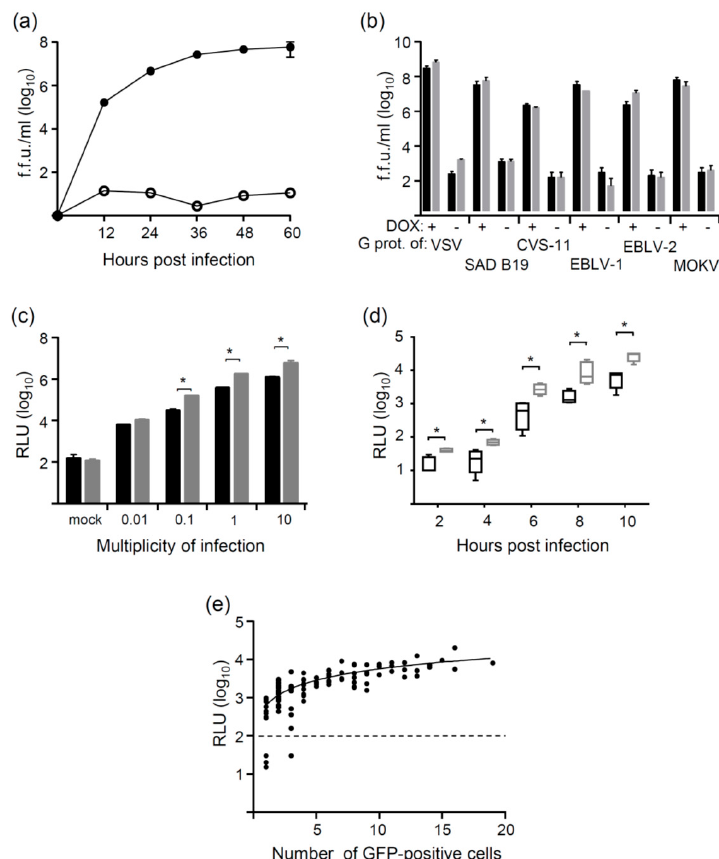
(e.g., Vero cells) did not release any progeny virus following infection with any of the pseudotype viruses (data not shown).